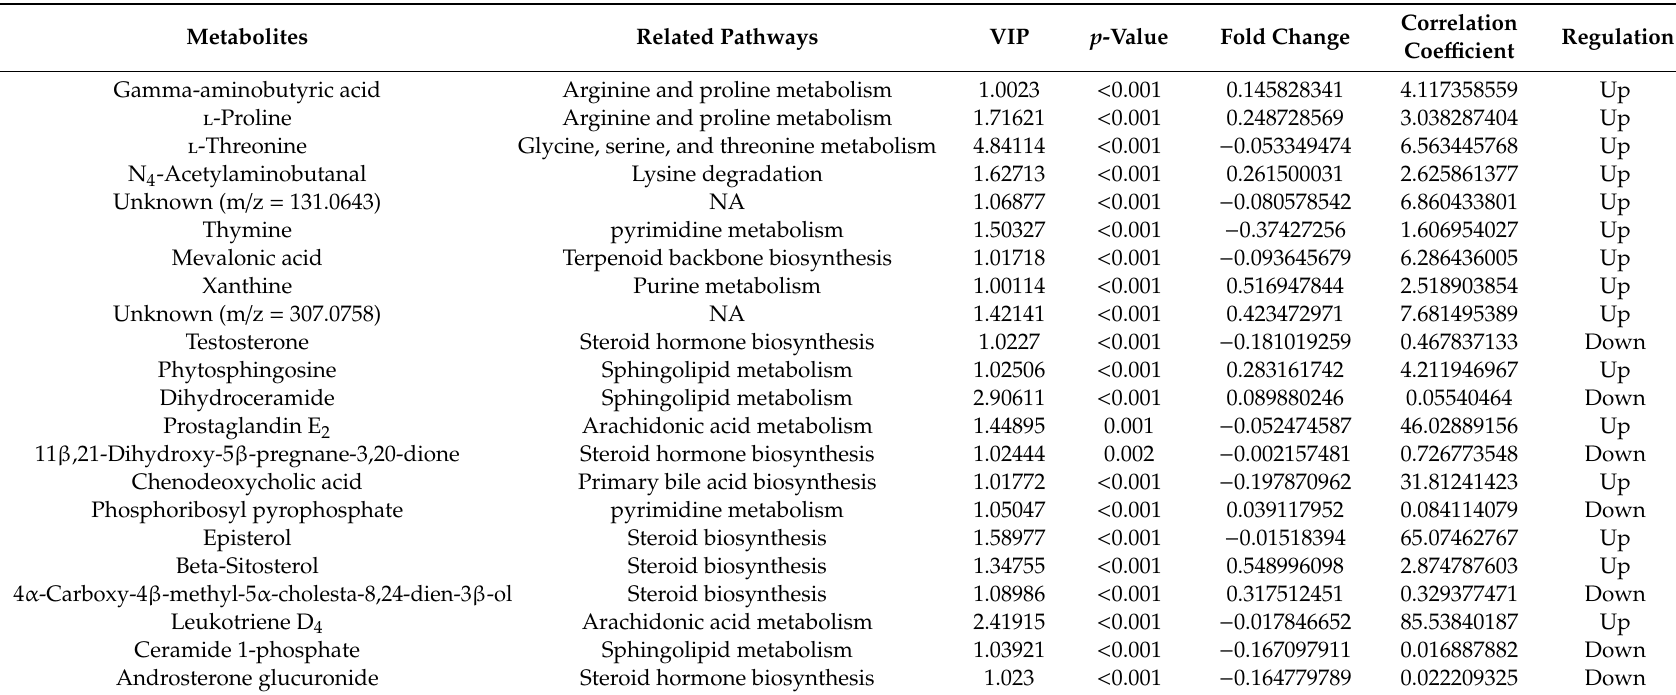
Table 1. Di ff erentially regulated metabolites between samples from patients with pre- and post-operative colorectal